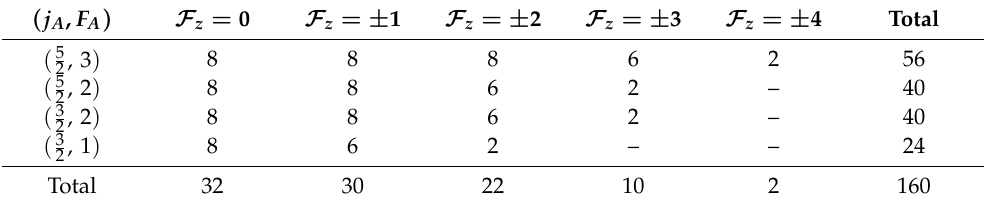
Table 1. Multiplicities are given for reference ( nD j = 3/2, j = 5/2 ;2 S ) states, in the submanifolds with different F z = 0, ± 1, ± 2, ± 3, ± 4. For reference, we point out that the highest F z value ( F z = 4) is reached for reference states composed of the F = 3 hyperfine submanifold of the D 5/2 states with maximum projection on the quantization axis, and the F = 1 hyperfine submanifold of the S 1/2 states, also with maximum projection on the quantization axis. Entries marked with a long hyphen (–) indicate unphysical